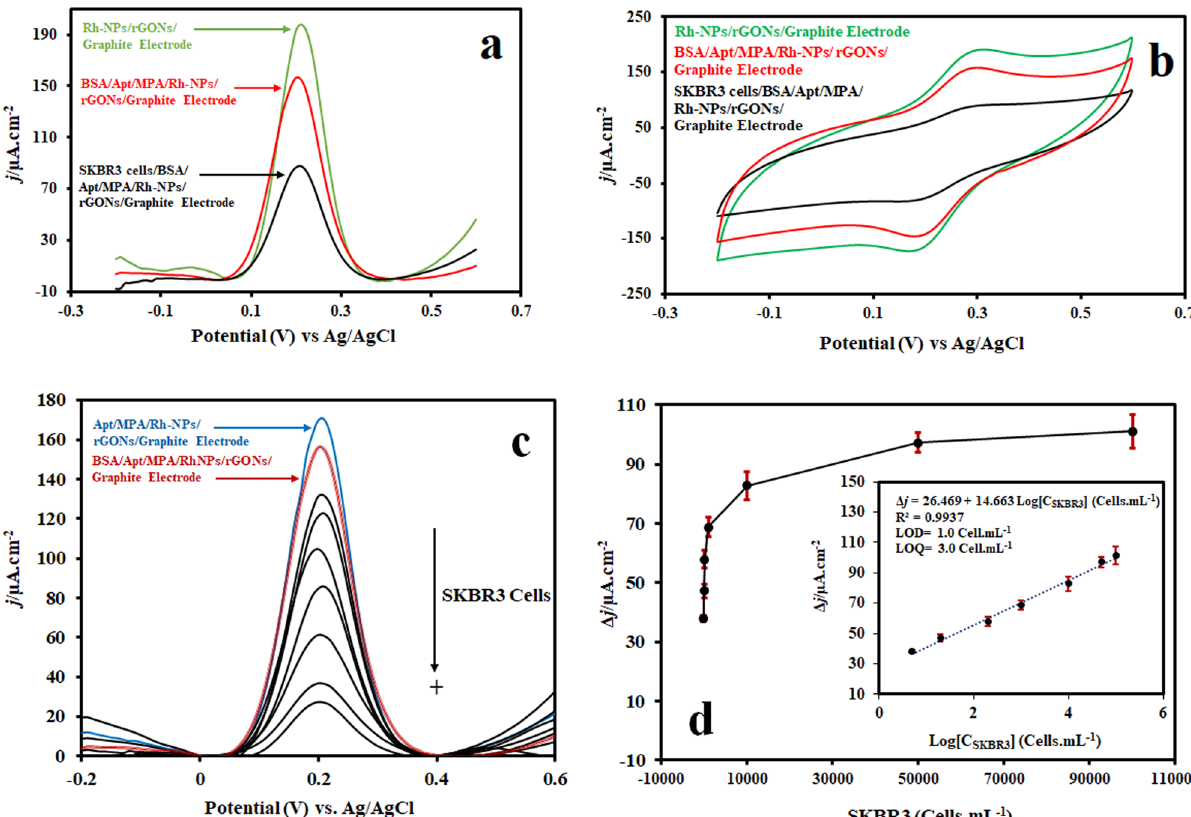
Figure 7: ( a ) DPV graphs of modi fi ed graphite electrode in various stages ( 10 3 cells/mL of SKBR3 cells ) , ( b ) CV plots of modi fi ed graphite electrode in various stages ( 10 3 cells/mL of SKBR3 cells ) , ( c ) DPV responses of the g - aptasensor with di ff erent concentrations of SKBR3 cells ( 5, 20, 200, 10 3 , 10 4 , 5.0 × 10 4 , 10 5 cells/mL ) , and ( d ) dependence of current density on concentration changes in the SKBR3 cells ( inset: the linear portion of calibration curve )